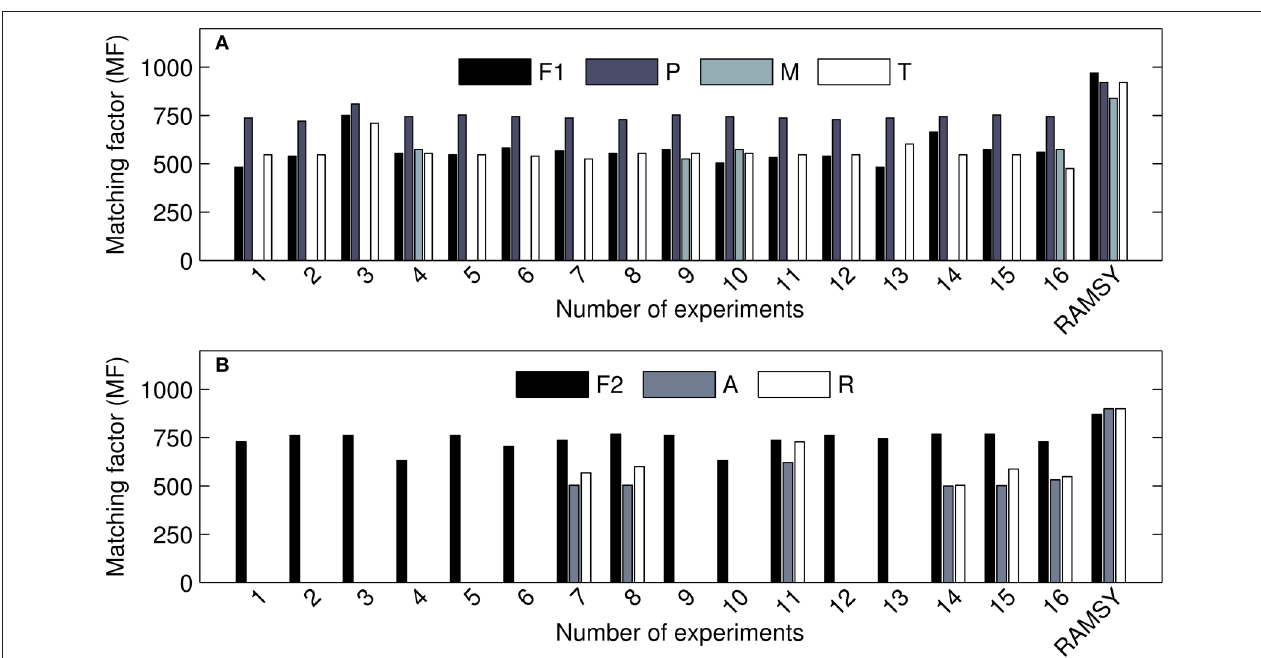
FIGURE 4 | MF values for detected metabolites using AMDIS in different parameter sets (1–16) and RAMSY. (A) represents the coeluted peak at 7.4–7.6 min; F1: C 12 FAME std (dodecanoic acid); P: pyroglutamic acid; M: 4-aminobutyric acid; T: threonic acid. (B) represents the coeluted peak at 37.7–38.0 min: F2: C 28 FAME std.; A: α -tocopherol; R: raffinose.